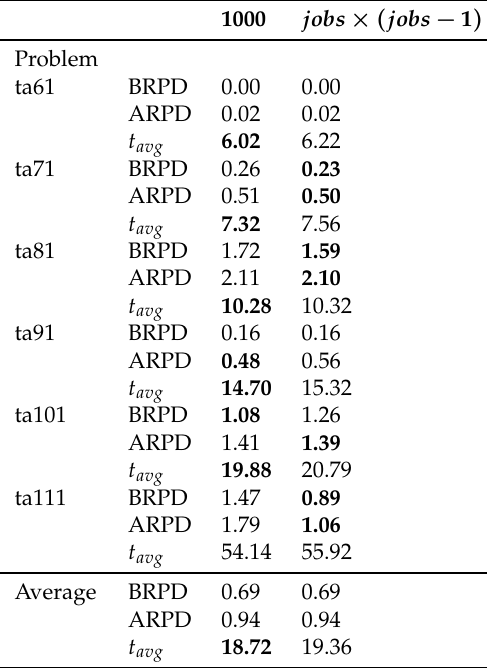
Table 7. Comparison of different iterations of the local search for large job